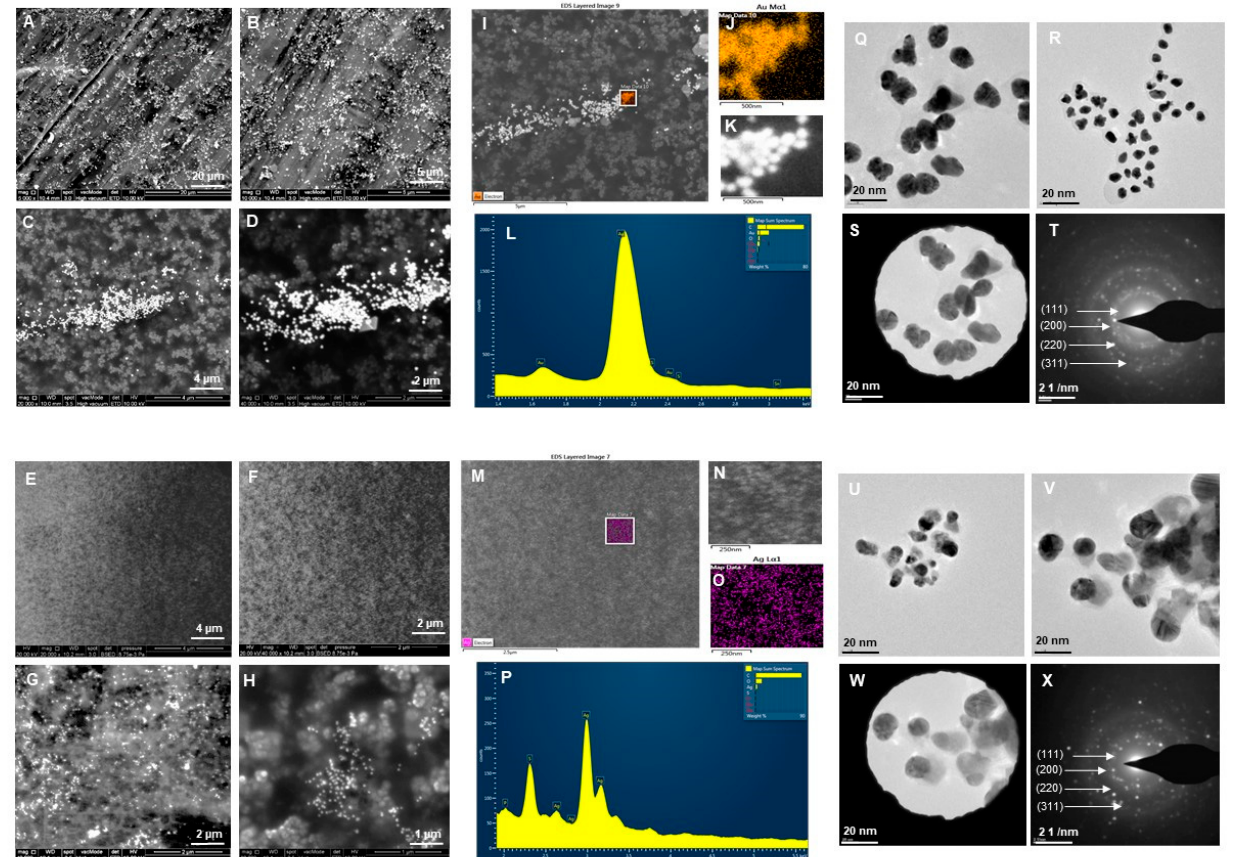
Figure 3. Structural analysis of RB-AuNPs and RB-AgNPs. For RB-AuNPs, ( A – D ) SEM images of nanoparticles at different scales, ( I – K ) Elemental mapping of RB-AuNPs showing scanned image of NPs with gold element distribution (orange), ( L ) EDX spectrum of the elemental mapped region showing sharp peak for gold element. ( Q , R ) TEM image of RB-AuNPs, ( S , T ) SAED pattern. For RB-AgNPs, ( E – H ) SEM images of nanoparticles at different scales, ( M – O ) Elemental mapping of RB-AgNPs showing scanned image of NPs with silver element distribution (pink), ( P ) EDX spectrum of the elemental mapped region showing highest peak for silver element. ( U , V ) TEM image of RB-AgNPs, ( W , X ) SAED pattern.